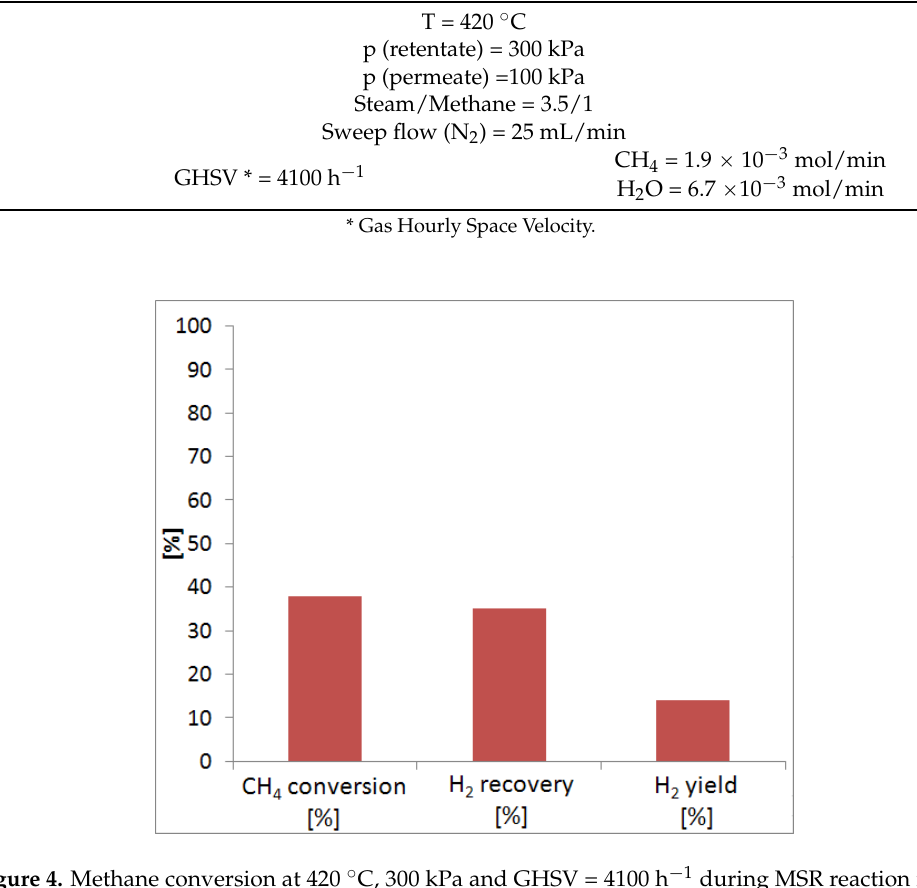
Figure 4. Methane conversion at 420 °C, 300 kPa and GHSV = 4100 h − 1 during MSR reaction in the Pd ‐ Au MR.